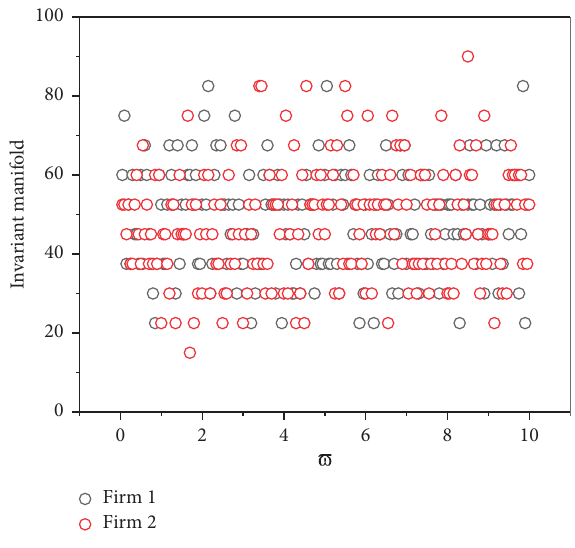
Figure 6: Premarketing strategy results.